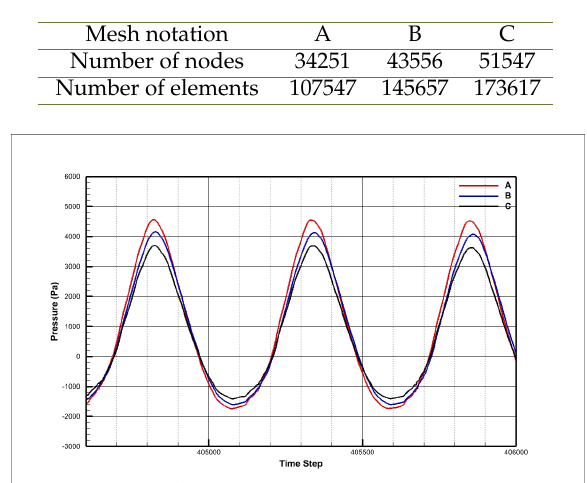
Fig. 3. The predicted local pressure variations for the three considered